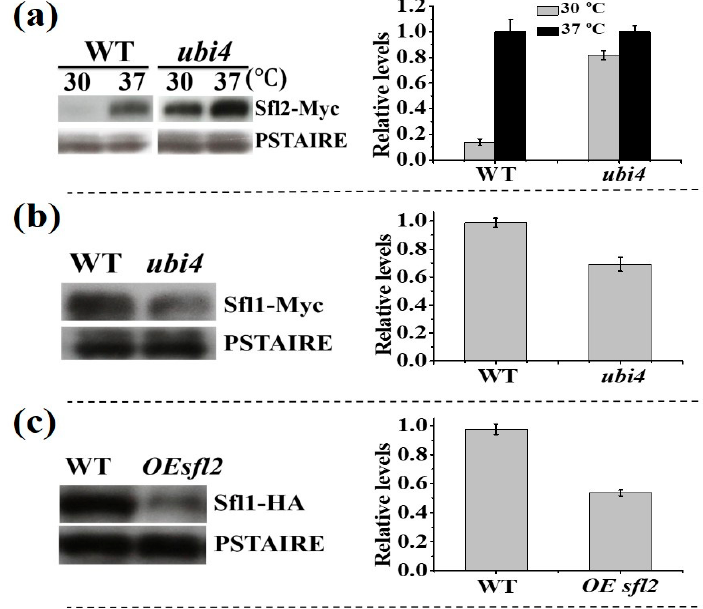
Figure 6. ubi4 mutant cells expressing ( a ) Sfl1-Myc or ( b ) Sfl2-Myc were induced for hyphal growth with 5% FBS at 37 °C in the presence or absence of 150 μ M BDSF. Samples were taken for Western blot analysis at the time points as indicated (left panels). Relative protein expression levels (right panels) were analyzed using ImageJ software. Normalizations were performed against the corresponding protein signal at 2.5 h ( a ) and 0 h ( b ), respectively.